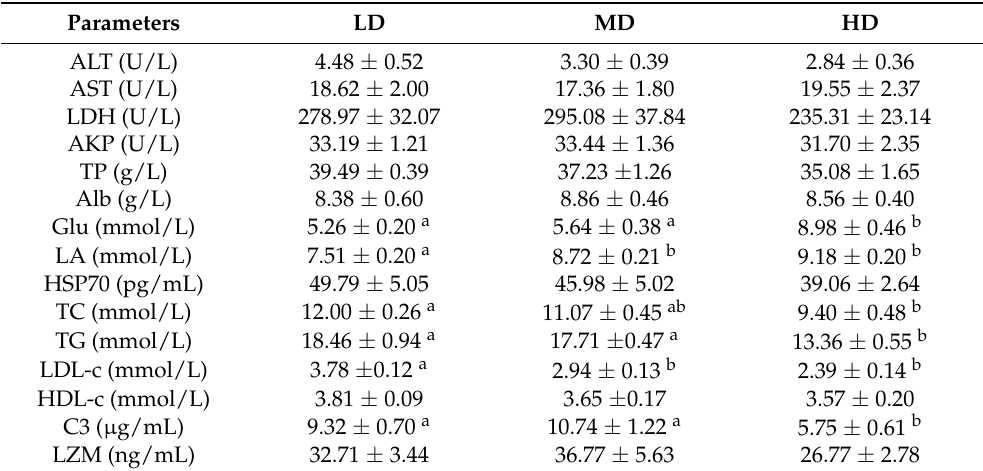
Table 2. Physiological parameters in the plasma of M. salmoides reared at different densities in an integrated rice–fish farming system after 90 days of